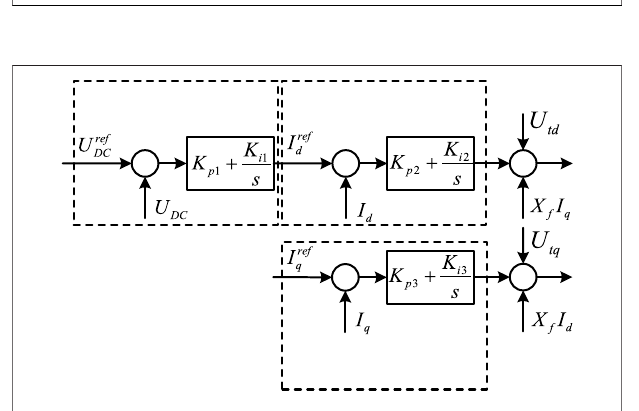
FIGURE 4 | Block diagram of the inverter control system.